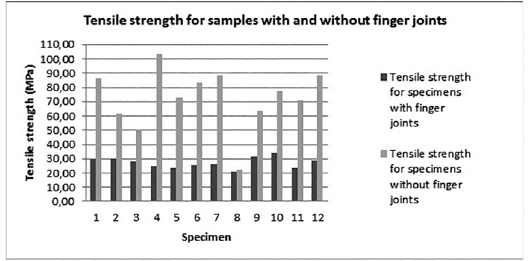
Figure 10: Chart comparing tensile strength values of samples with and without finger joints. Table 6: Variability of tensile values between specimens with and without finger joints. Specimen